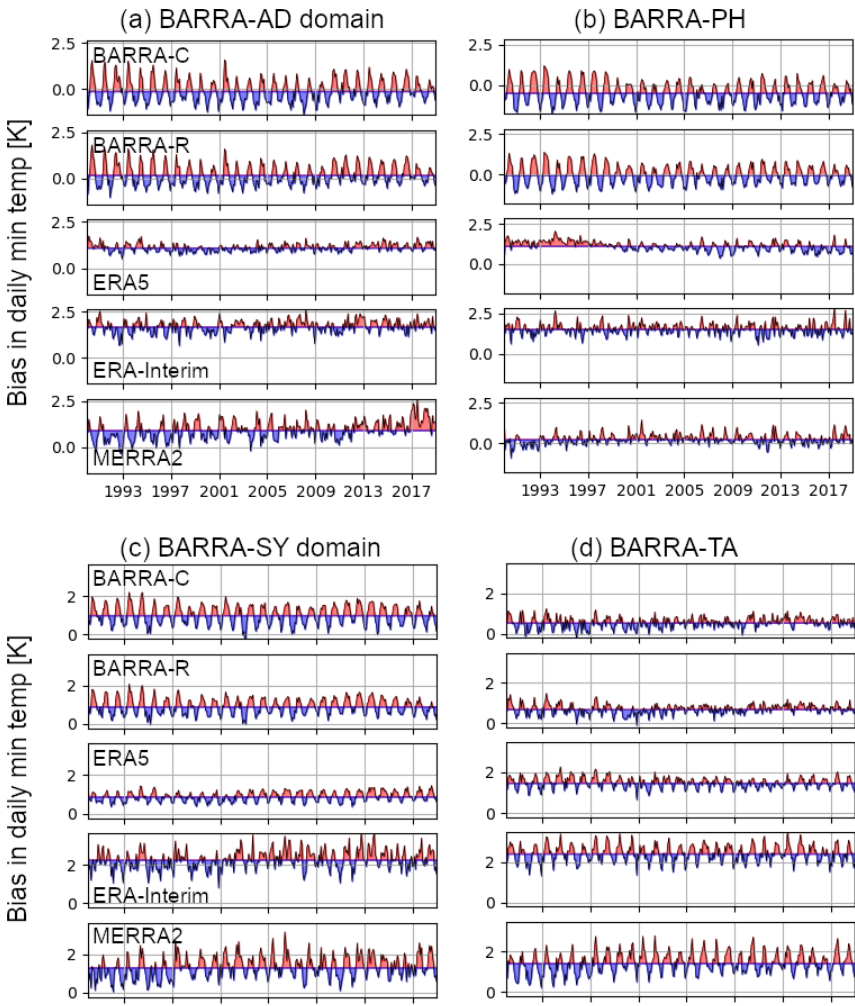
Figure 5. As Fig. 4 but for daily minimum